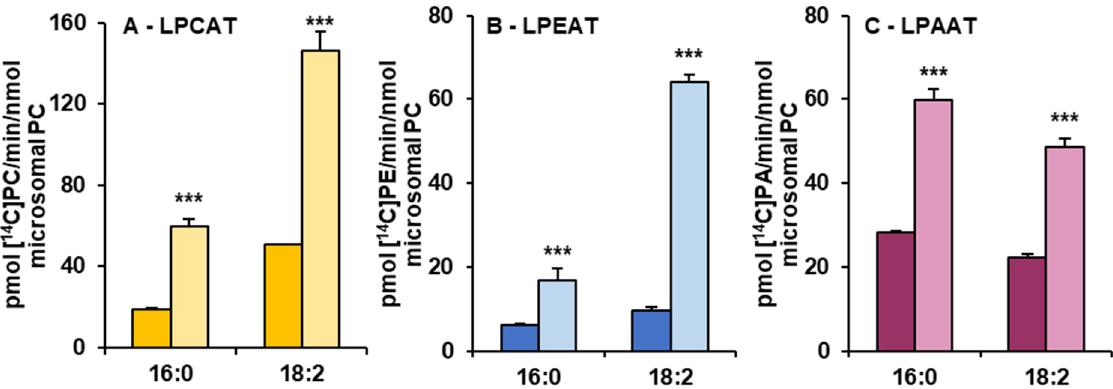
Figure 4. The activity of LPCAT ( A ), LPEAT ( B ) and LPAAT ( C ) enzymes of microsomal fractions of C. sativa leaves from two different growth conditions: in vivo and in vitro . Assays contained appropriate sn -1-LPL as fatty acid acceptor and 16:0-CoA or 18:2-CoA (indicated on the figure as 16:0 and 18:0, respectively) as fatty acid donors. Mean values and SD are presented (data from at least three independent assays). Asterisks indicate significant difference between the activity of the tested LPLATs (in assays with tested acyl donors) present in leaves cultivated in vivo (left bar) and in vitro (right bar) in a two-tailed Student’s t -test: *** p ≤ 0.001.